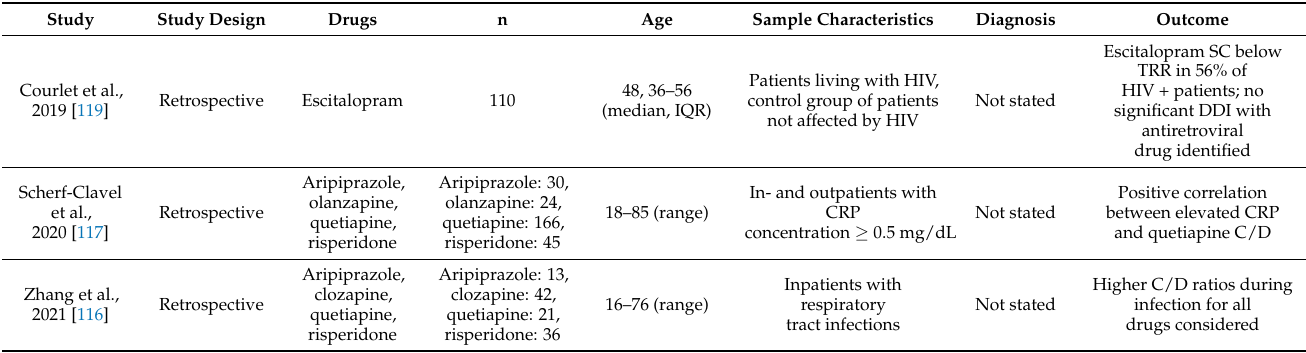
Table 8. Original articles on the use of TDM in patients with systemic inflammation or other medical